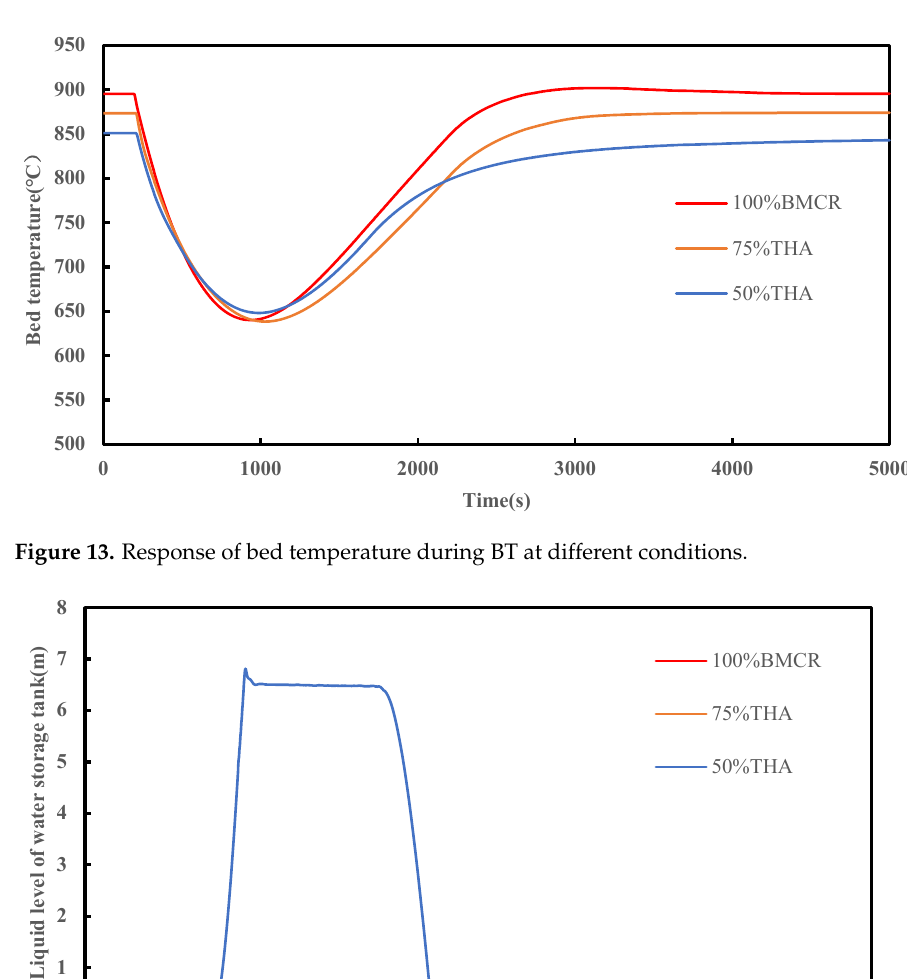
Figure 12. Response of reheated steam temperature during BT at different conditions.